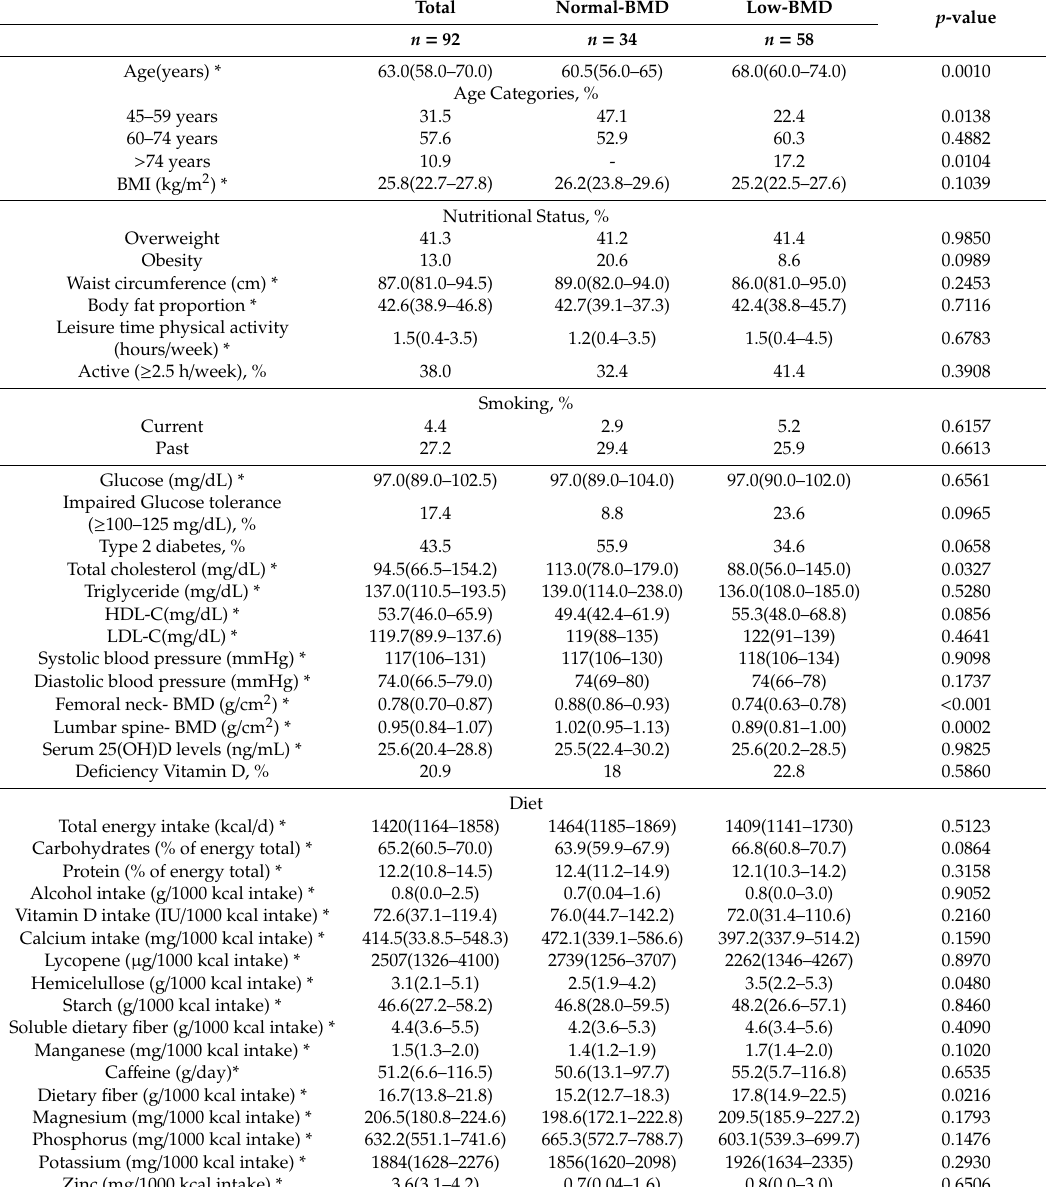
Table 1. Characteristics of selected postmenopausal women of the Health Workers Cohort